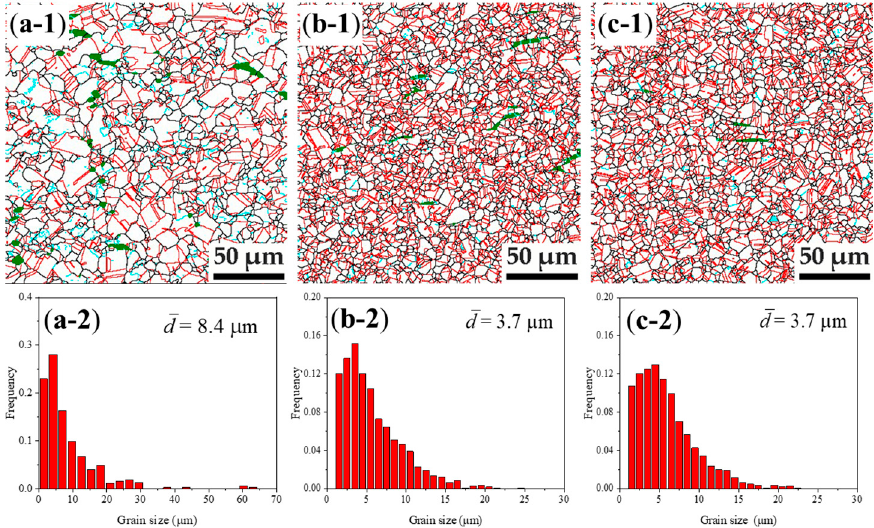
Figure 4. High temperature deformation microstructure: ( a-1 ) to ( c-1 ) the grain boundary maps, black lines present HAGBs (>15°), cyan lines present LAGBs (2°-15°), red lines present TBs, green color present BCC phase; ( a-2 ) to ( c-2 ) austenite grain size distribution of specimens compressed at 1050 °C 0.01 s − 1 , 1050 °C 1 s − 1 and 1050 °C 10 s − 1 , respectively.